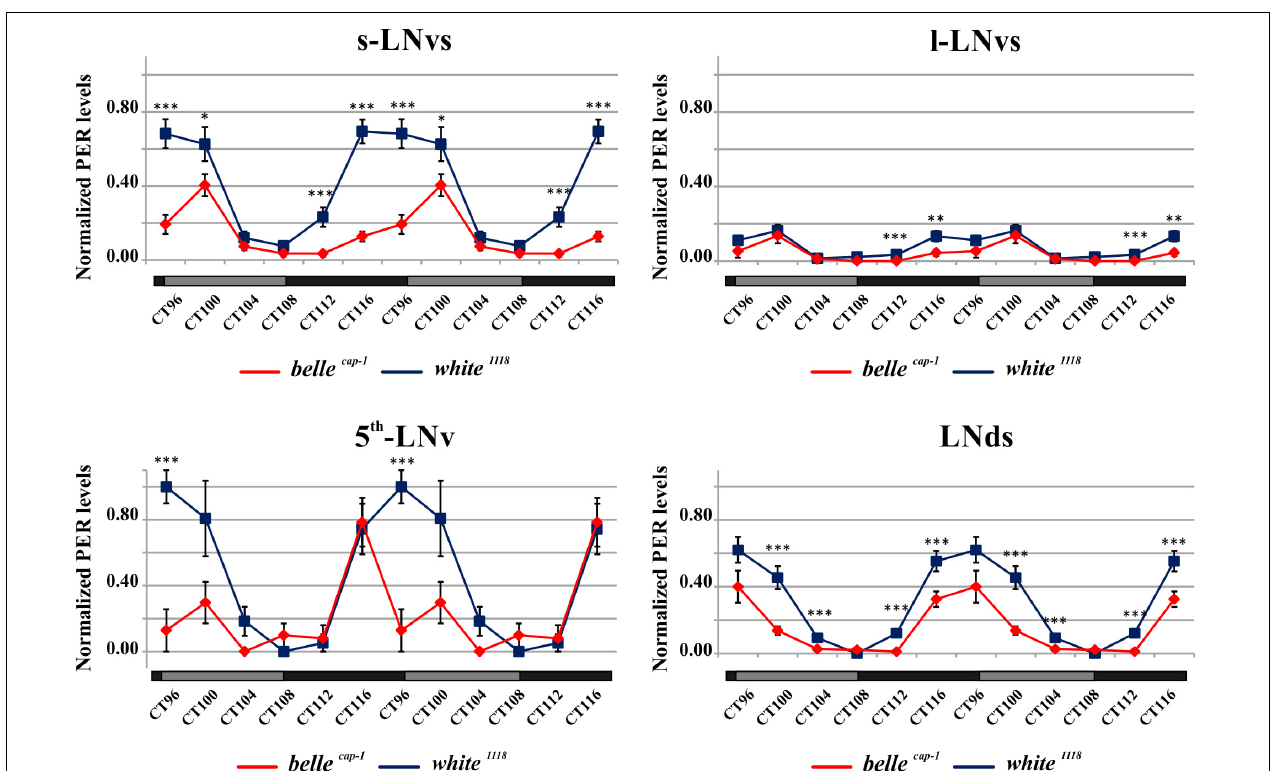
FIGURE 7 | Altered PER expression in belle cap − 1 mutant in constant conditions. PER quantifications in the clock Lateral Neurons of belle cap − 1 mutant flies in constant darkness. Flies were first entrained for 2 days in LD and then analyzed after 4 days of DD. Only arrhythmic flies were collected every 4 h and stained for PER expression during the 5th day of DD. Peak value was set to 1 and the rest of the values were normalized accordingly. Data are shown as double-plotted. t -Test: ∗∗∗ p < 0.005, ∗∗ p < 0.01, ∗ p < 0.05.